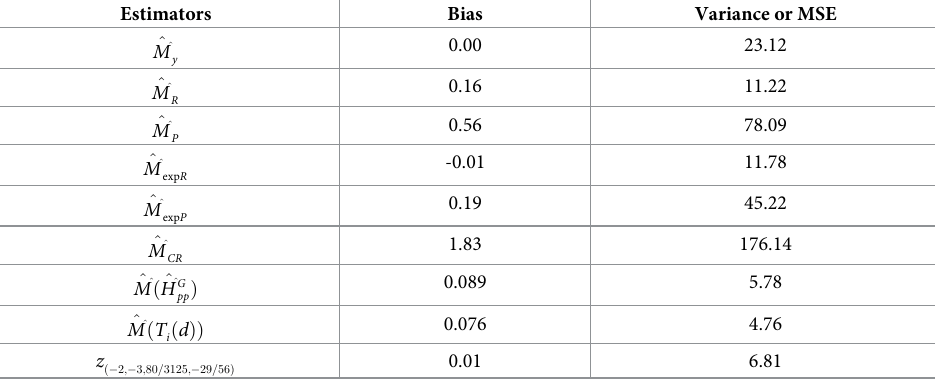
Table 4. Bias and MSE values of members of the proposed class of estimators for population 3.